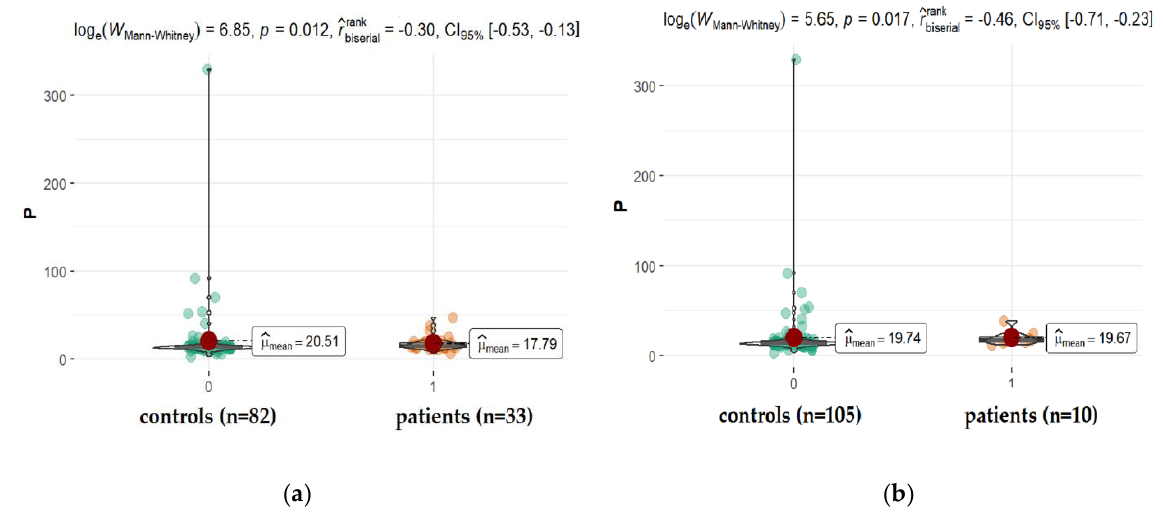
Figure 7. Statistical significance of differences in P content in AH of patients with coexisting diabetes ( a ), and retinopathy ( b ) compared to controls.